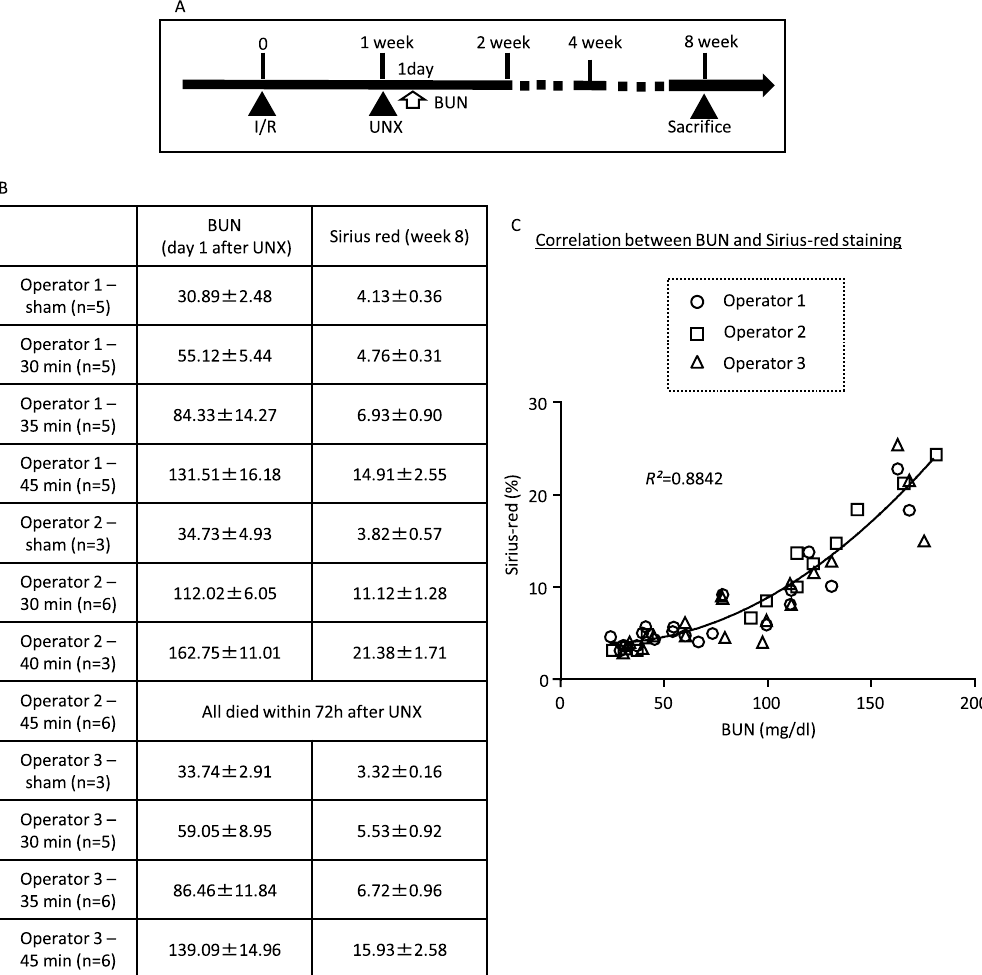
GTCGTA-3 ′ , 5 ′ -TGGCACCACTAGTTGGTTGTCT-3 ′ . Relative mRNA levels were determined using the 2 −ΔΔ Ct